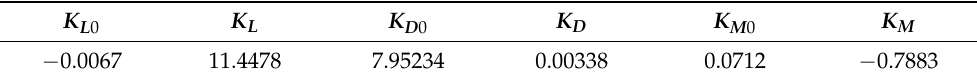
Table 2. Values of